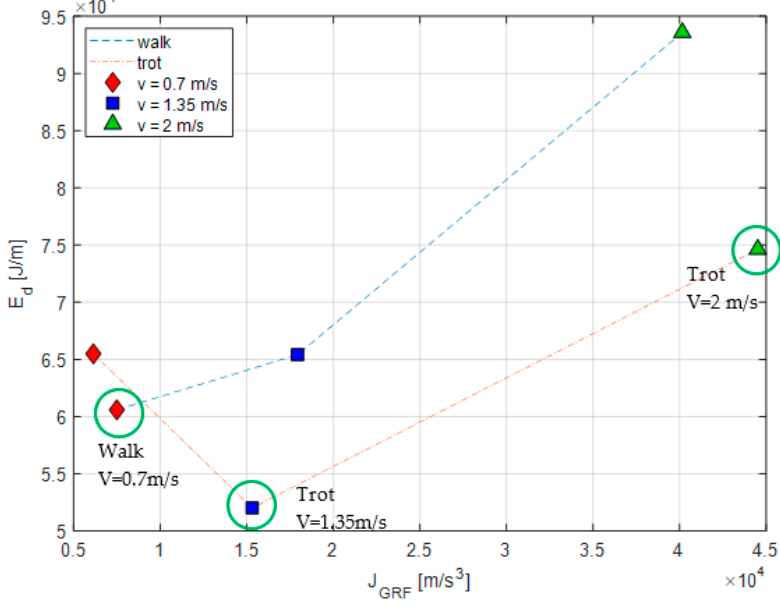
Figure 17. Trot gait energy 𝐸 (cid:3031) for different speeds and time cycles T.